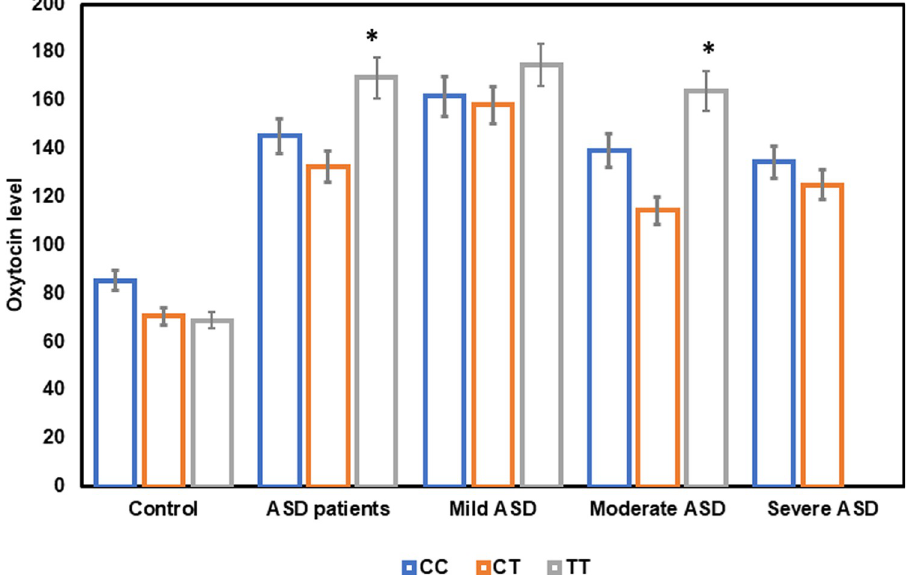
Fig 2. Bar chart of the oxytocin levels according to the three oxytocin gene polymorphism genotypes in autism patients and controls.